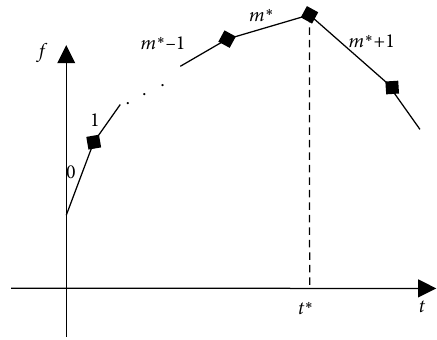
Figure 4: The profit function with respect to delivery time